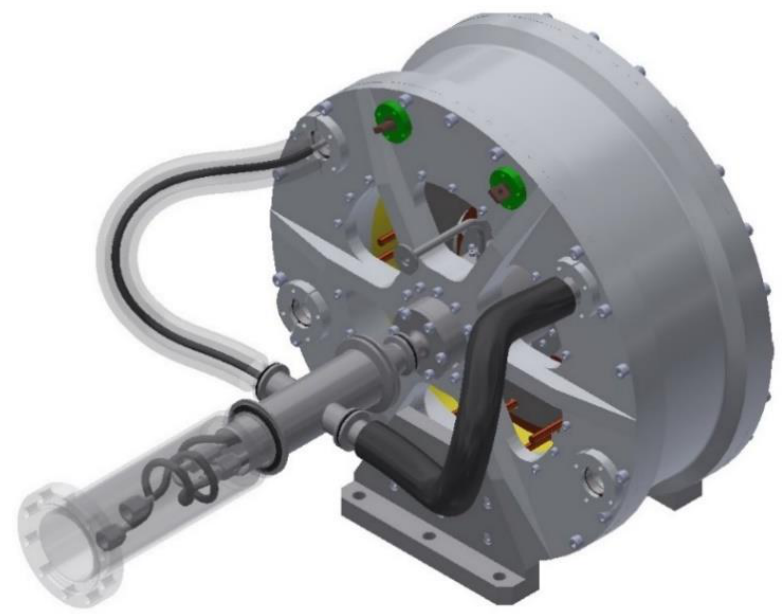
Figure 4. HTS motor from GREEN and SAFRAN for aeronautic applications.